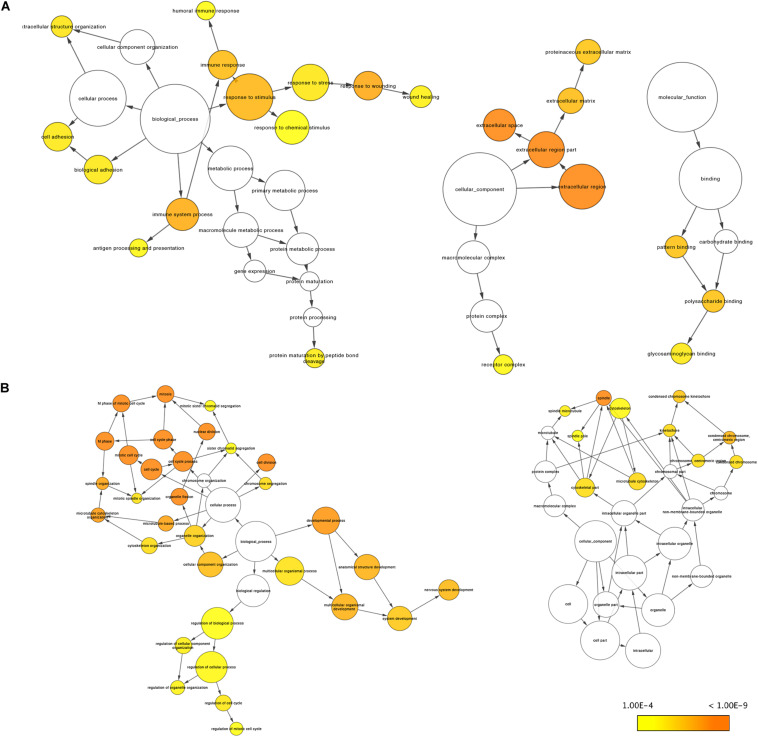
Gene Ontology analyses of robust up-regulated (A) and down-regulated (B) DEGs by BINGO plug-in. There is no enrichment for molecular function in B. The size of the nodes is proportional to the number of genes in that term. Significance decreases from dark orange (p = 1.00E-9) to yellow (p = 1.00E-4).